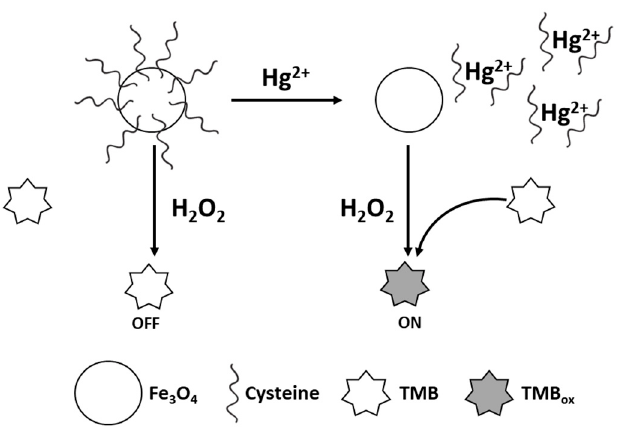
Figure 8. Principle for sensing of Hg 2+ based on Hg 2+ -triggered peroxidase-mimicking activity of Cys-Fe 3 O 4 nanoparticles. (Adapted with permission from [102]. Copyright © 2018, Elsevier B.V. All rights reserved.).